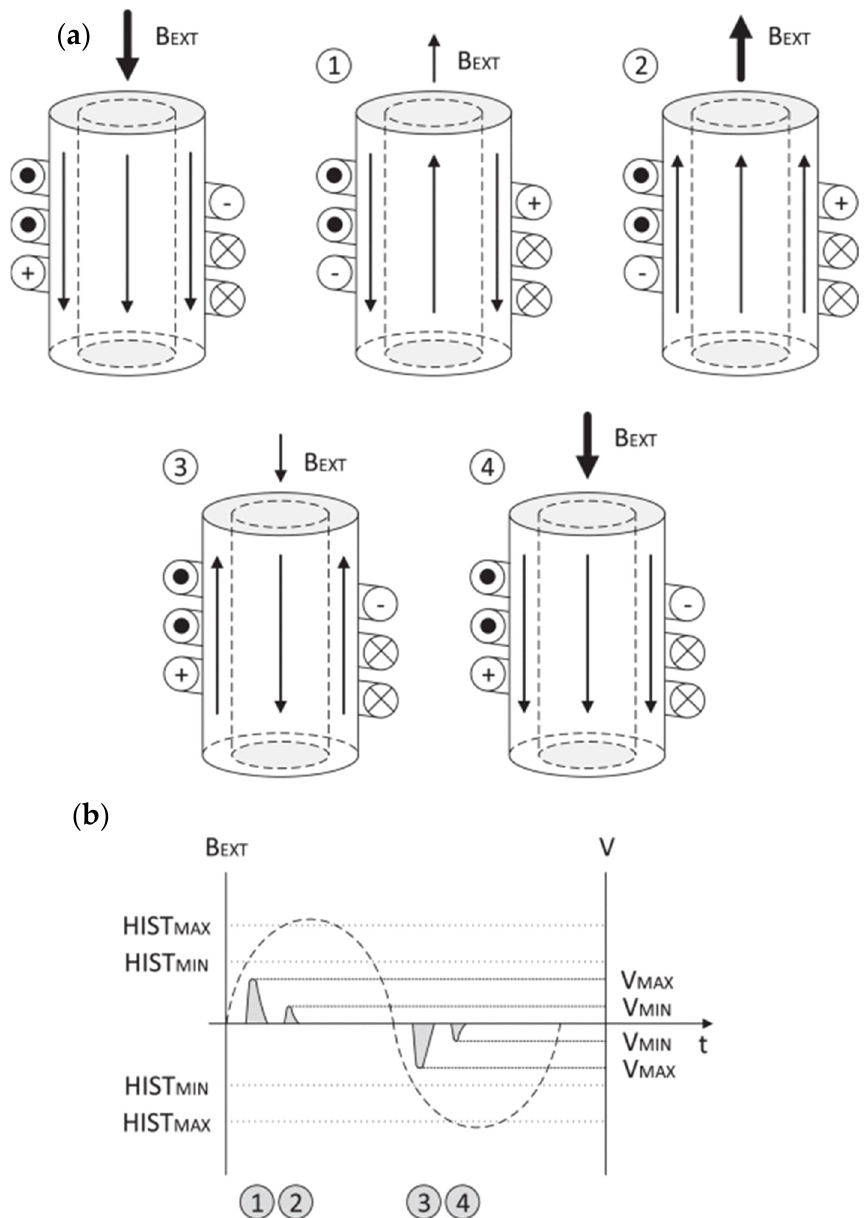
Figure 1. Working principles of a Wiegand sensor showing the ( a ) various states of Wiegand wires along with the corresponding external field (B EXT ) and ( b ) output pulsed voltages (V, triangle-shaped peaks) detected in the pick-up coil as a function of the cyclic changing external field (intensity indicated through dashed curve). © 2020 IEEE. Reprinted with permission from